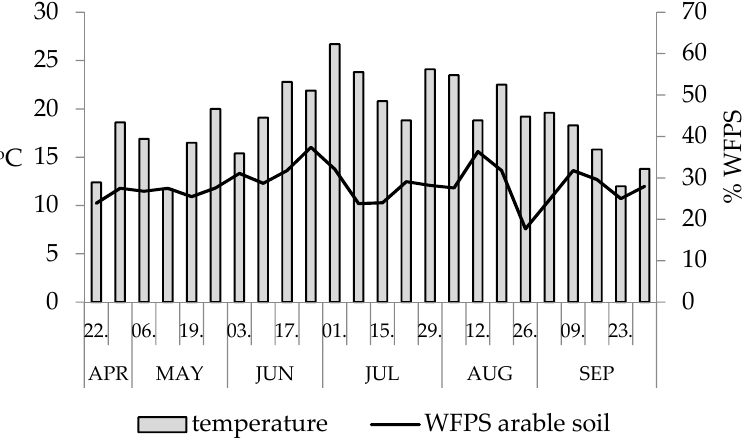
Figure 2. Daily average temperature and soil moisture (% water ‐ filled pore space ‐ WFPS).